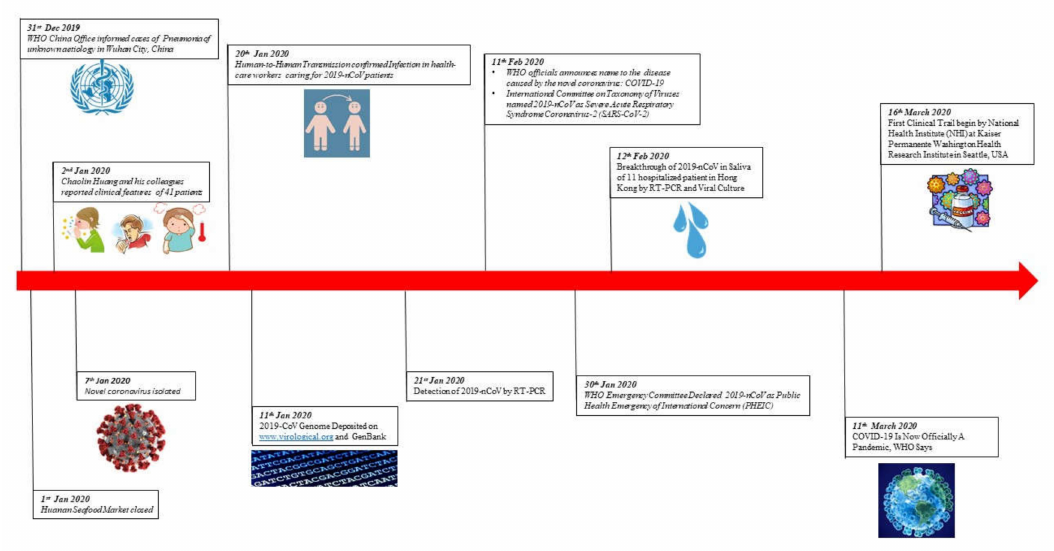
Figure 1. Events related to the 2019-Novel Coronavirus (2019-CoV)